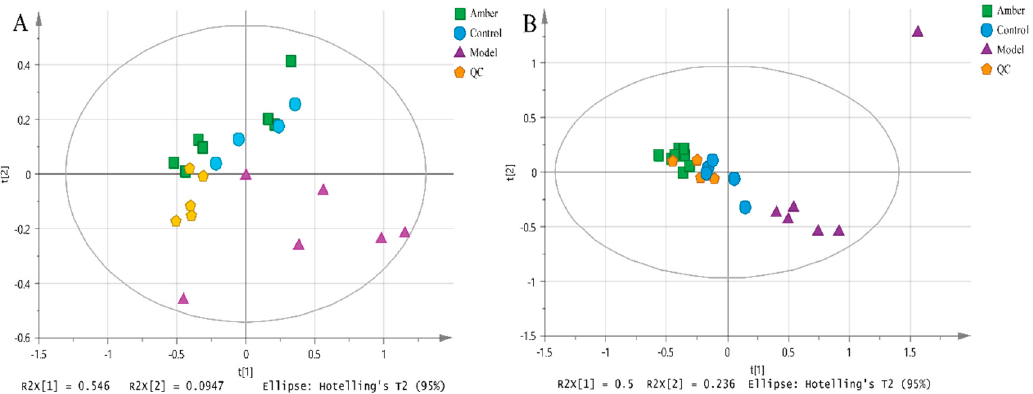
Figure 4. PCA scores scatter plot for control group, model group and amber group. ( A ) positive mode, R2X (cum) = 0.641, Q2 (cum) = 0.461; ( B ) negative mode, R2X (cum) = 0.836, Q2 (cum) = 0.449.